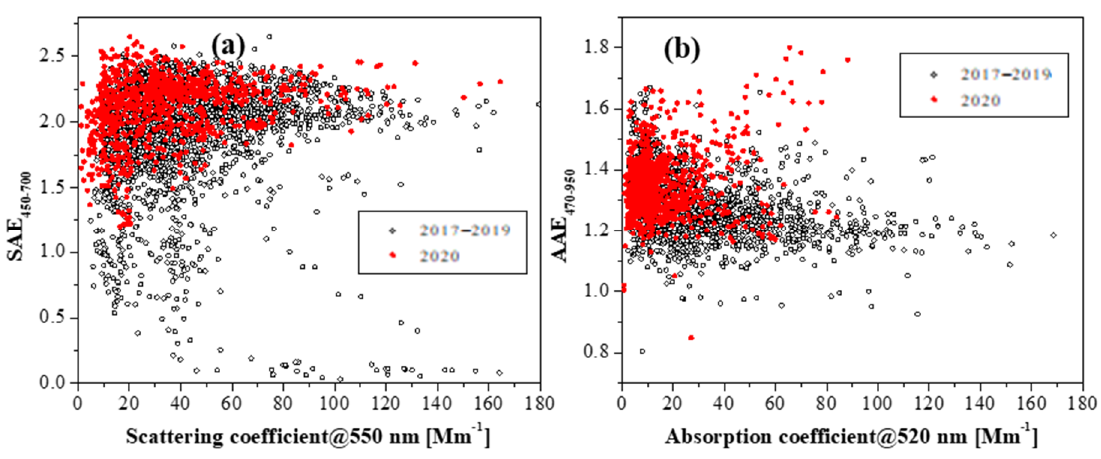
Figure 9. Correlation between b sca and SAE ( a ) and between b abs and AAE ( b ) during the period 23 March–3 May for the years 2017–2019 and for 2020 (lockdown).